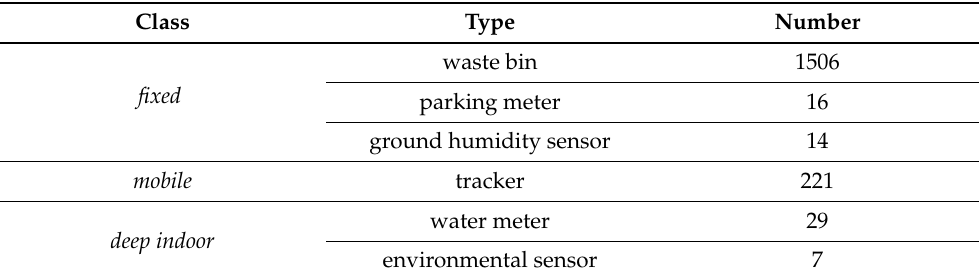
Table 2. Node types inside the LoRaWAN network.